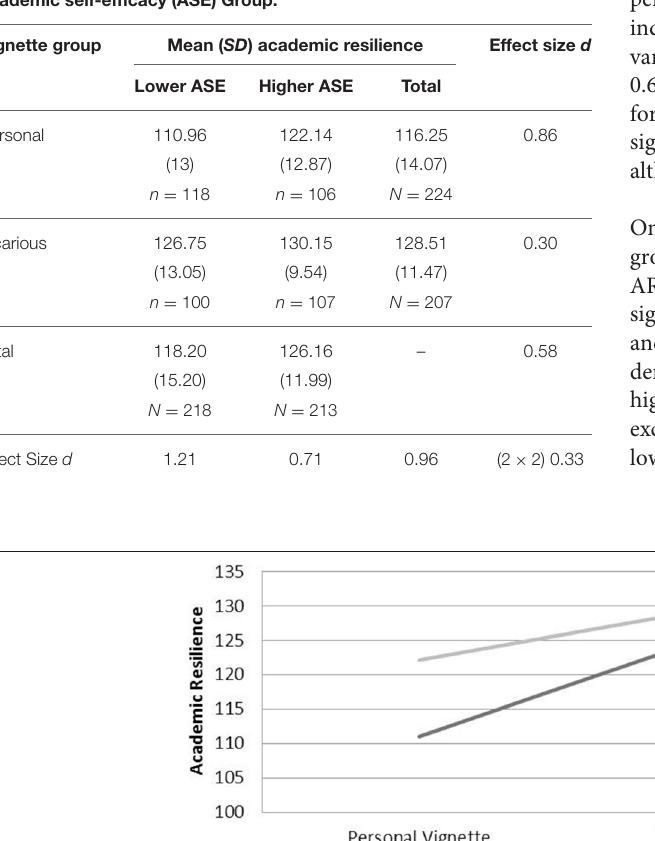
TABLE 4 | Mean academic resilience scores by vignette group and academic self-efficacy (ASE) Group.